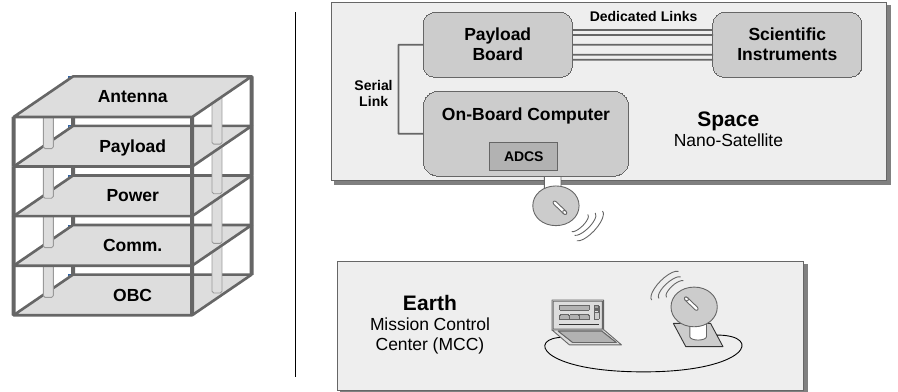
Figure 1. Nano-satellite system